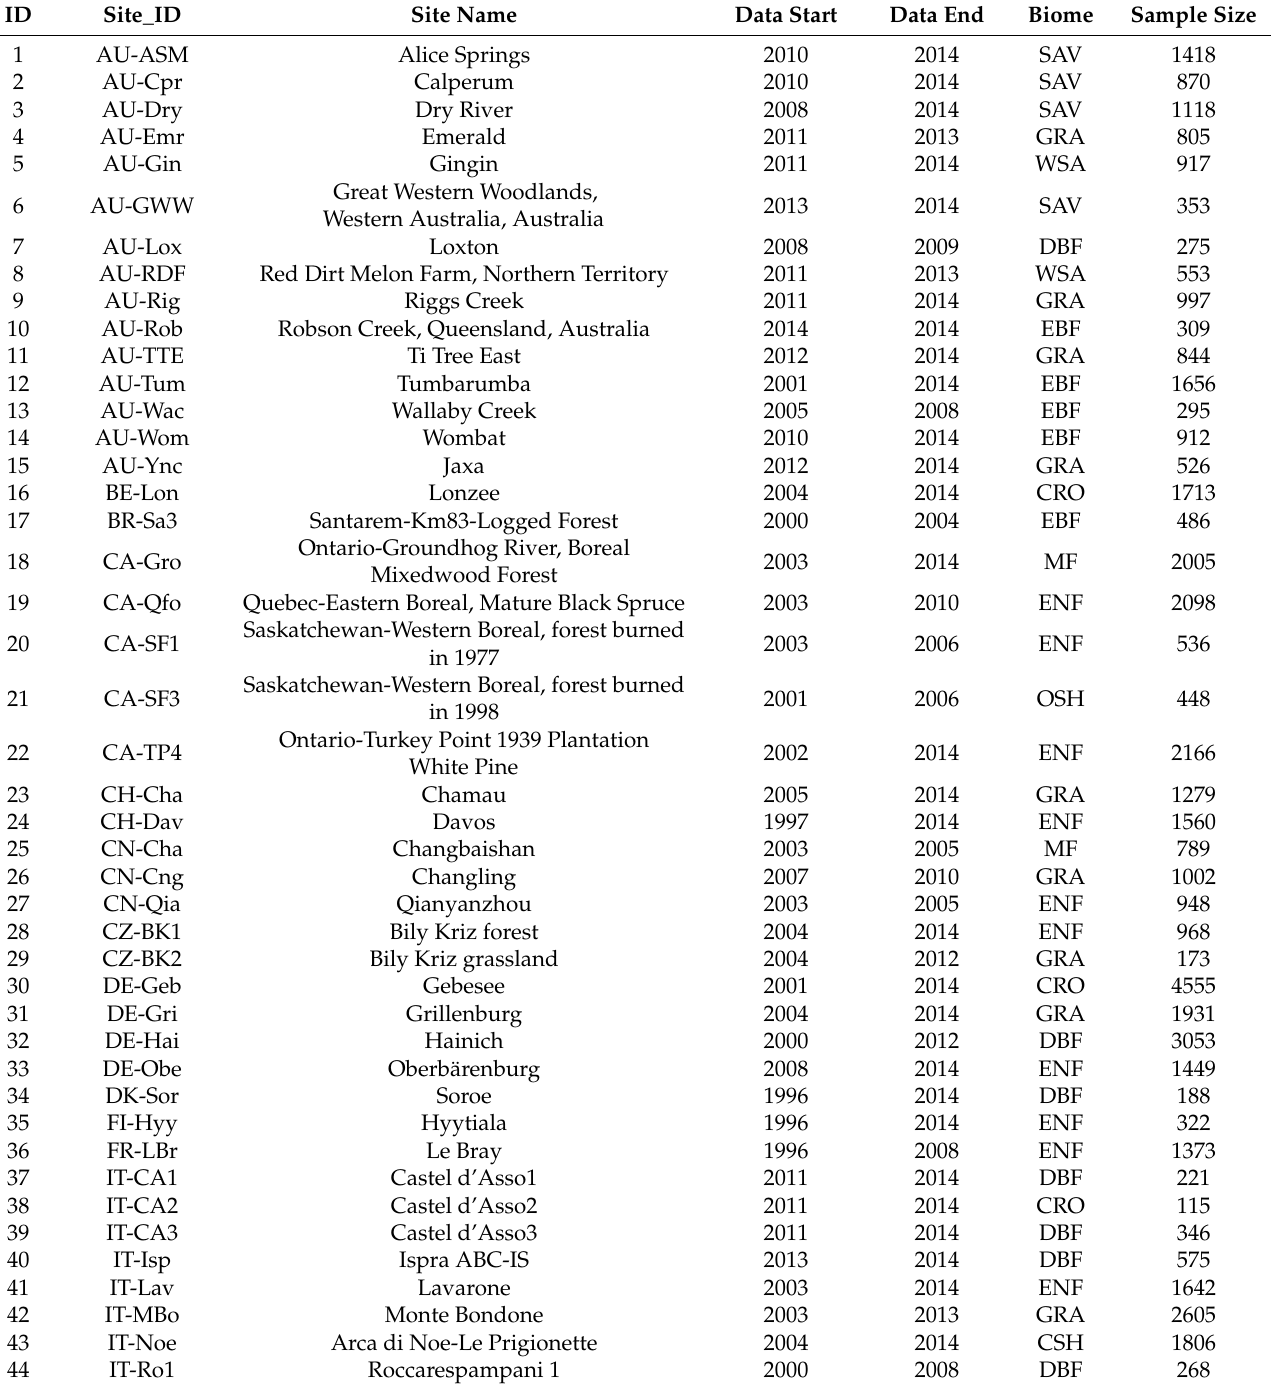
Table 2. FLUXNET sites used for this study. List of acronyms: DBF, deciduous broadleaf forest; EBF, evergreen broadleaf forest; ENF, was evergreen needleleaf forest; MF, mixed forest; GRA, grassland; CRO, cropland; OSH, open shrublands; CSH, closed shrublands; SAV, savannas; WSA, woody